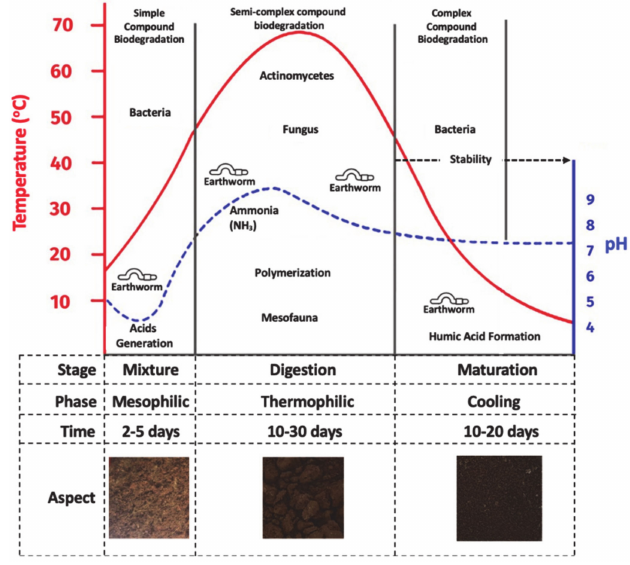
Figure 2. Vermicomposting process in the solid